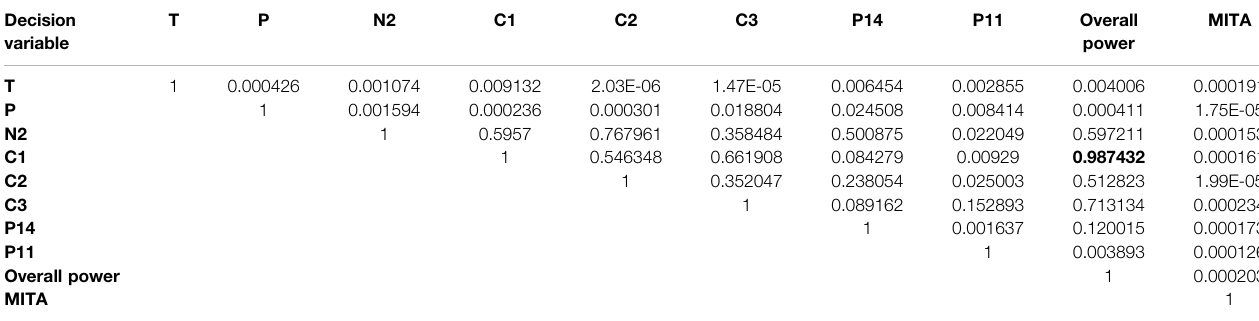
TABLE 4 | Summary of SMR-LNG process parameters in terms of R . 2 . Decision